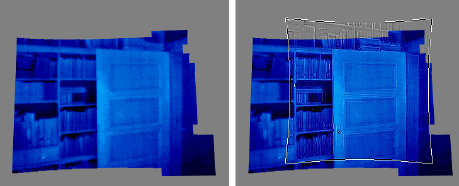
Figure 11: Transformed IR image before sharpening (left) and after sharpening (right).